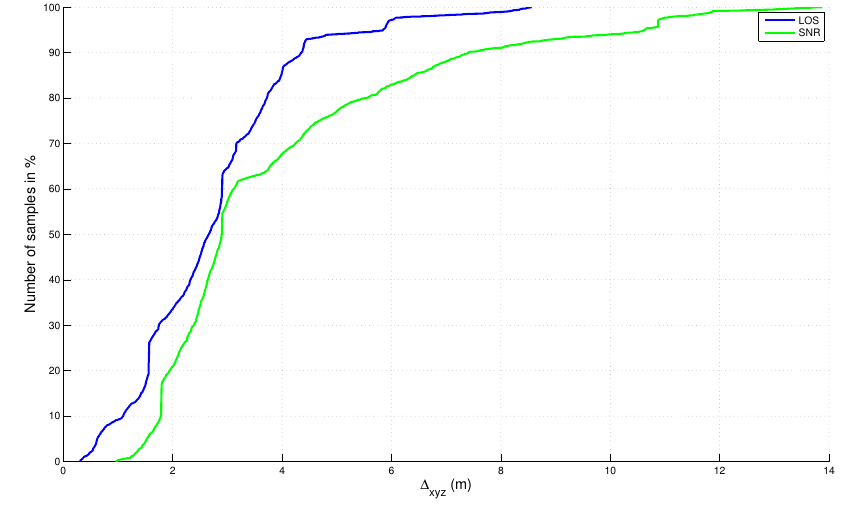
Figure 11. Cumulative distribution function of the absolute error in 3D for map-aided